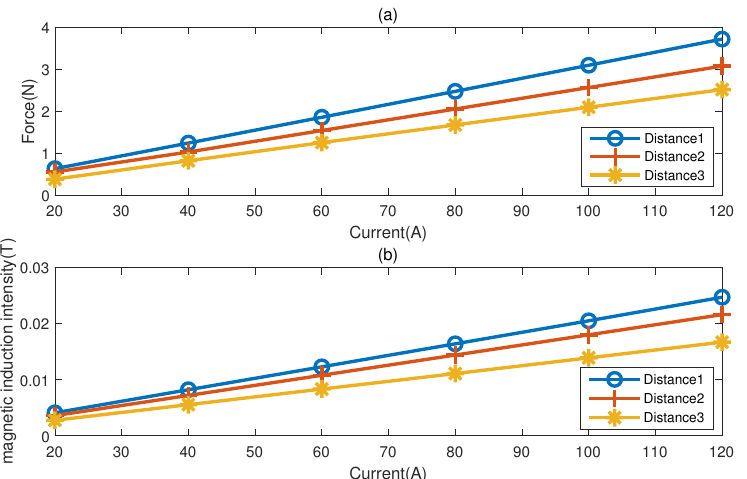
Figure 7. ( a ) The influence of coil distance on the relation curve between current and electromag- netic force. ( b ) The influence of coil distance on the relation curve between current and magnetic induction